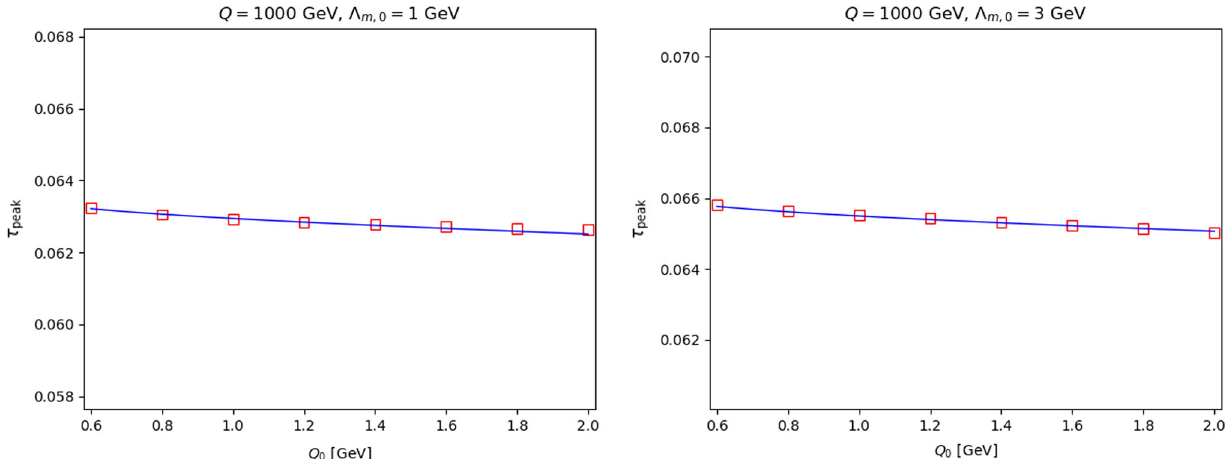
= 3GeV (right). The blue solid line depicts the result of the ana- (cid:3) m , 0 lytical computation while the red squares represent the data points from the parton shower